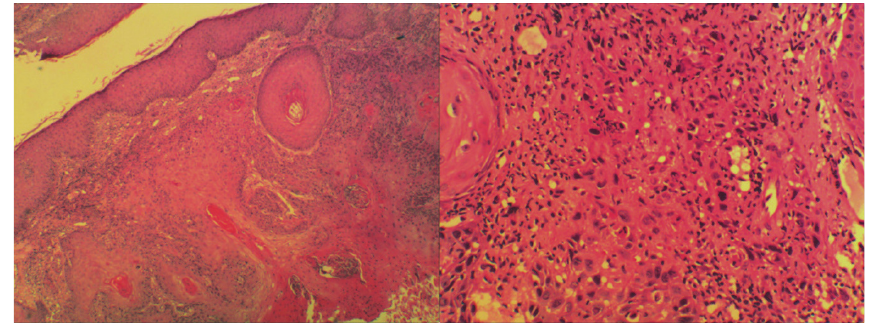
Figure 6: Section shows proliferative squamous cells invading the underlying stroma. The cells are hyperchromatic with a high N/C ratio and atypical